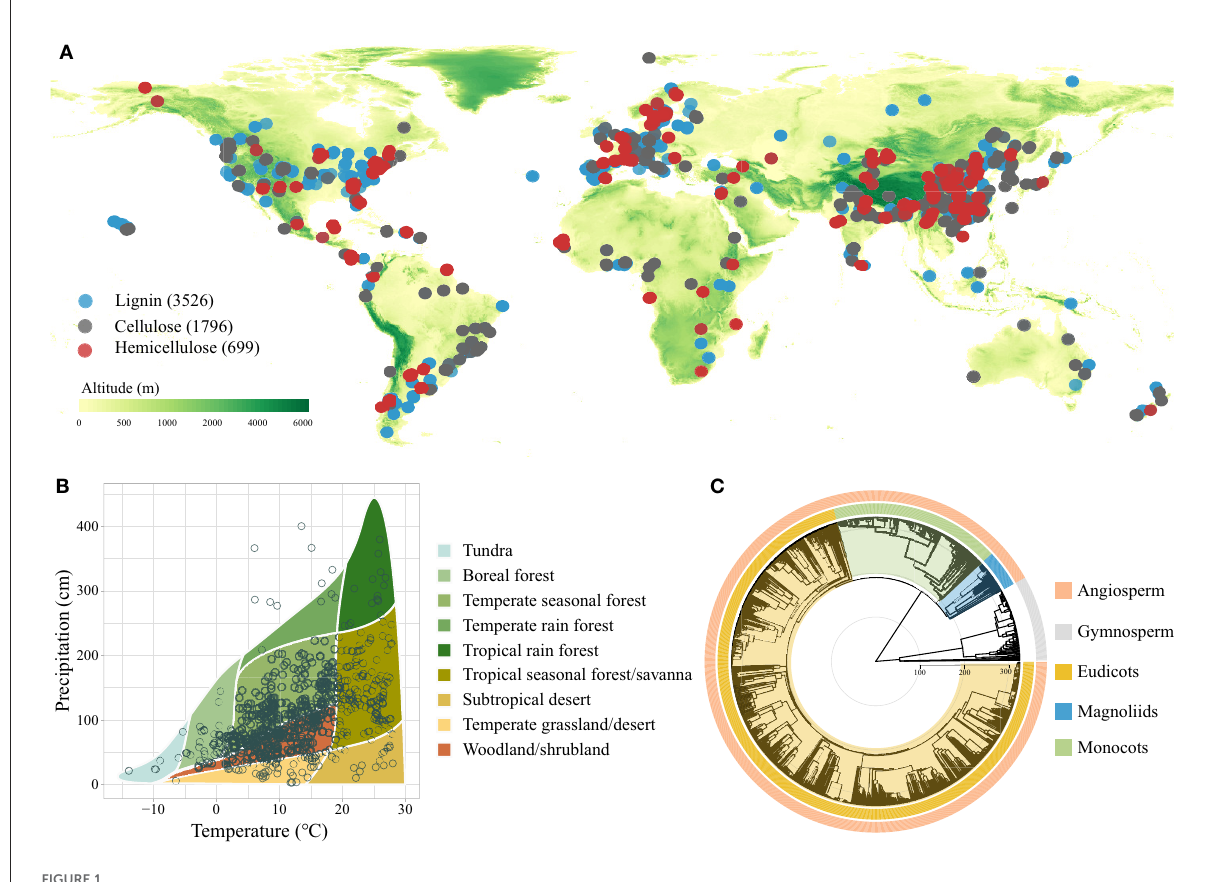
FIGURE1 Global map showing the distribution of study sites included in the dataset (A) , mean annual temperature and precipitation of study sites by biome (B) , and phylogenetic tree of plant species included in the study (C)